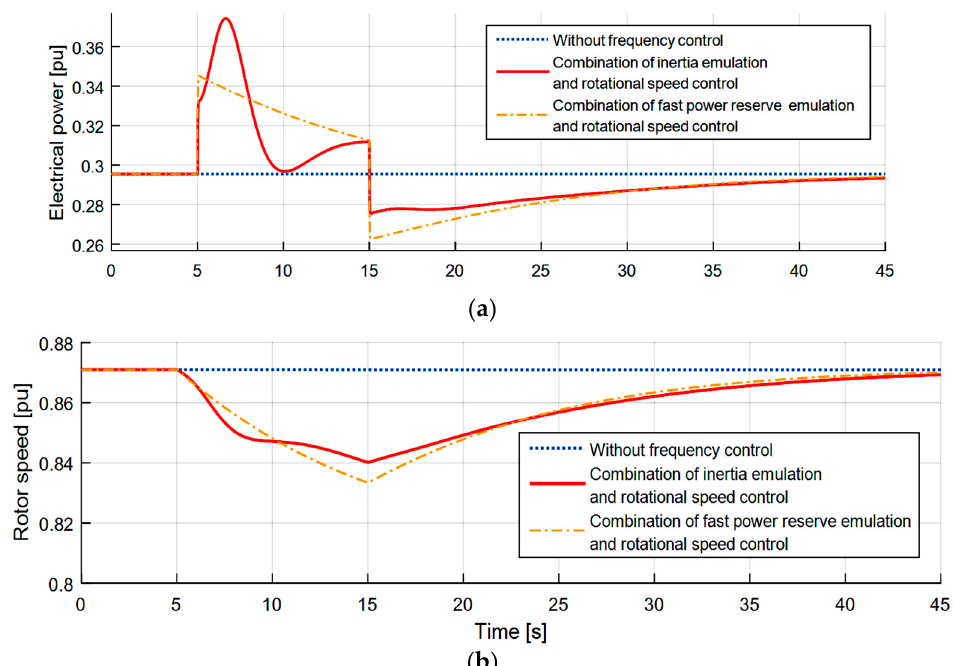
Figure 18. ( a ) Electrical power; and ( b ) rotor speed of VSWT in low wind speed case after frequency disturbance.